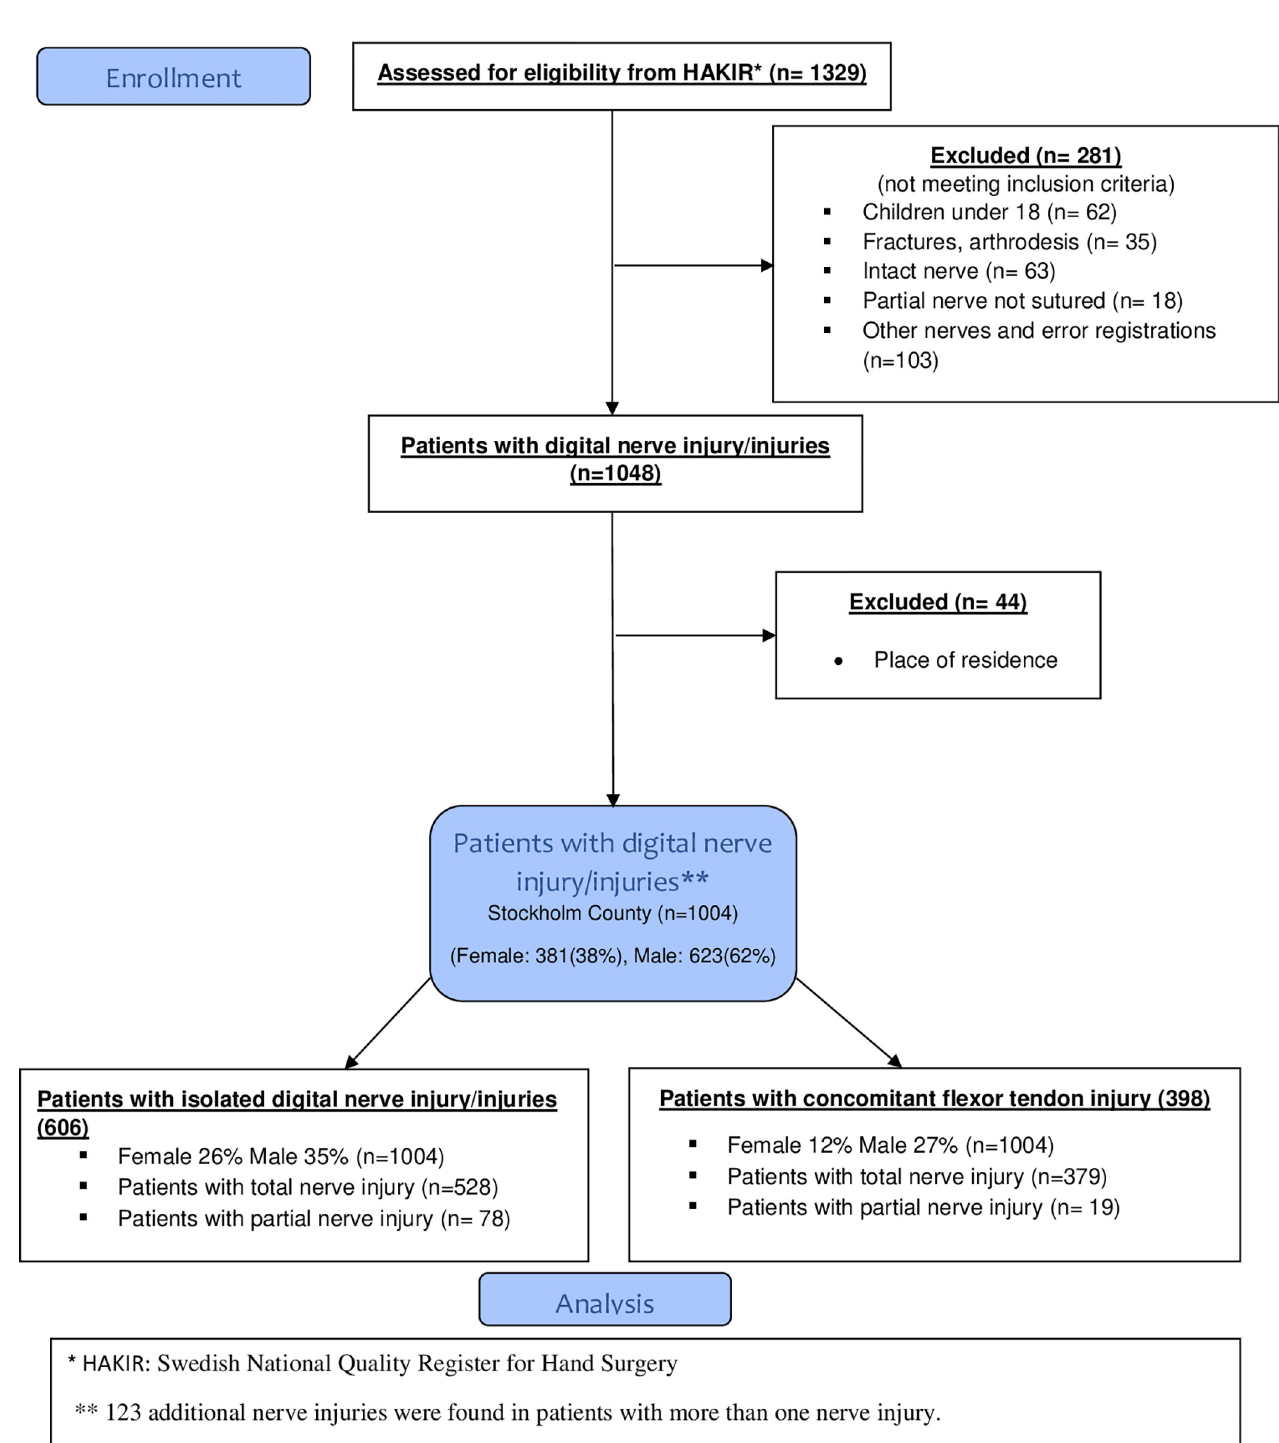
Fig 1. Flowchart of inclusion of digital nerve injury in Stockholm, Sweden 2012–2018.